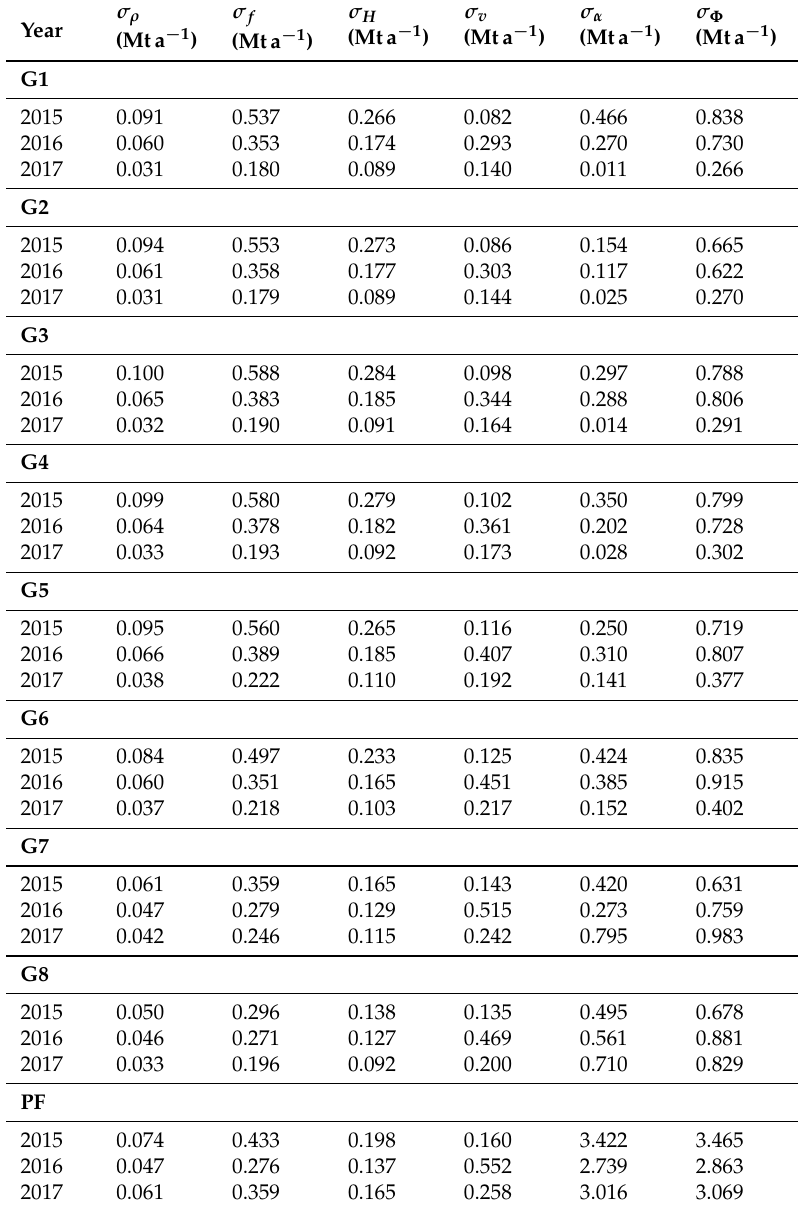
Table 1. Yearly error in ice discharge σ Φ and the single errors sources from the density of ice ρ , the width L , the ice thickness H , the ratio of the surface to the depth-averaged velocity f , as well as the magnitude v and direction α of the surface velocity vector. All errrors are provided in Mta − 1 . Ice thickness data are from the measurements of 2018 using the TIN